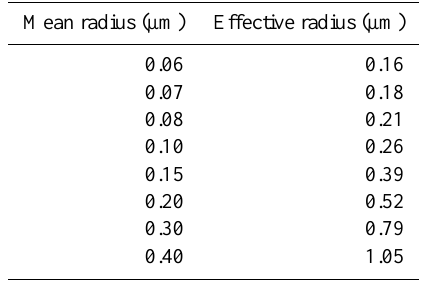
Table 2. Mean radii and effective radii used in the present